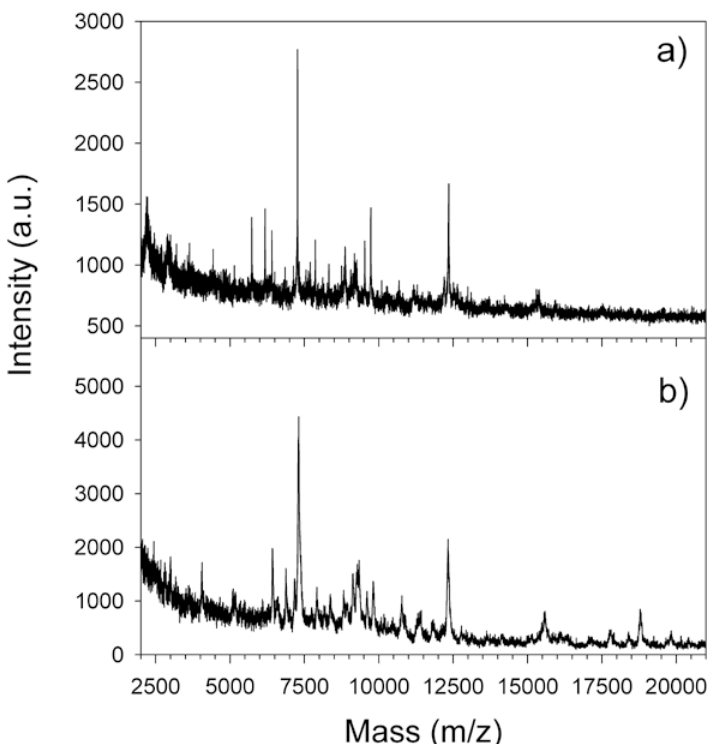
Fig.5 Mass spectra of Escherichia coli K12 XL1 blue with the matrix sinapinic acid; a) summed aerosol mass spectrum of 2000 aerosol particles (prepared off-line) and b) mass spectrum obtained with a standard MALDI mass